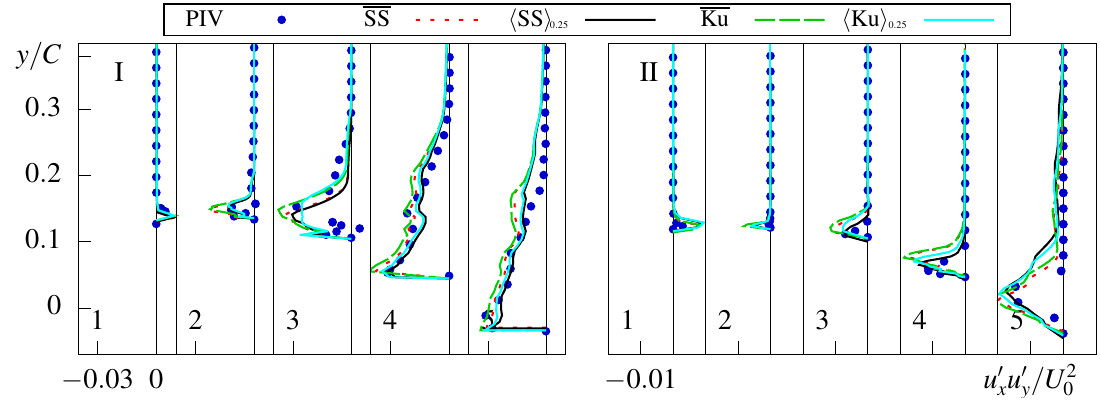
Figure 12. Similar to Figure 10 for the main component of shear stresses.